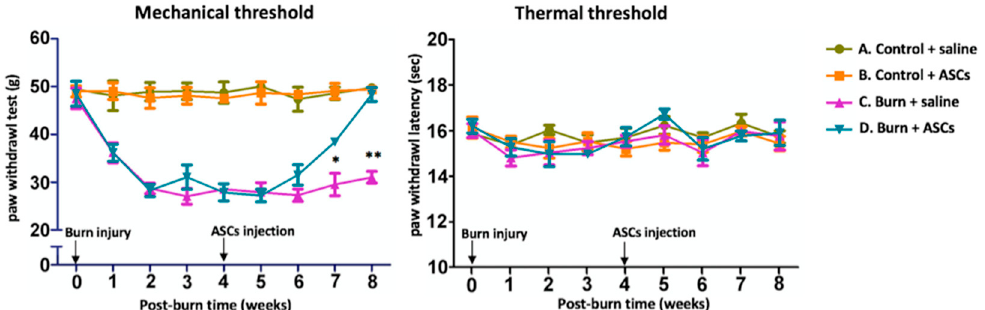
Figure 1. Increased mechanical threshold after ASC transplantations. Markedly decreased mechanical thresholds were observed after the burn injury at (i.e., in Groups C and D). The mechanical threshold had significantly improved in Group D at 3 weeks after ASC transplantation (4 weeks post-burn injury). The thermal thresholds of the four groups did not differ significantly within the 8-week study period. Each group contained six animals. Data are plotted as means ± standard errors of the means. (** p < 0.01 and * p < 0.05).